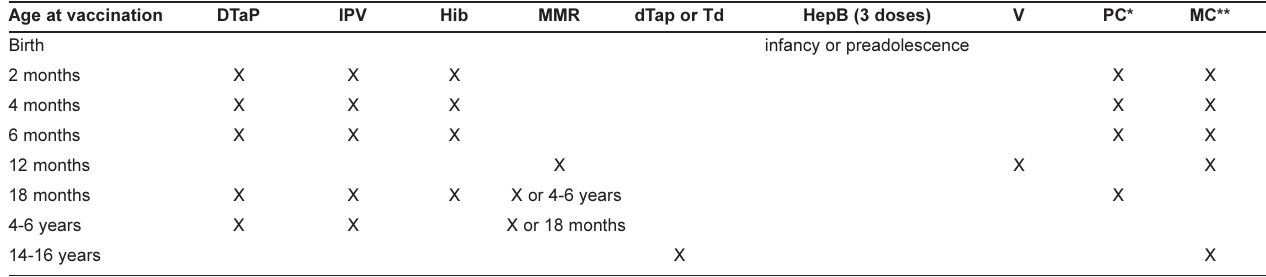
TABLE 1 National Advisory Committee on Immunization’s recommended immunization schedule for infants, children and youth Age at